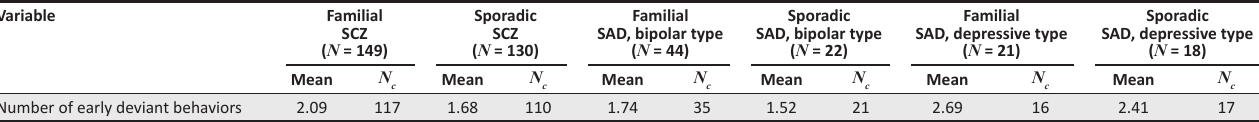
Number of early deviant behaviors